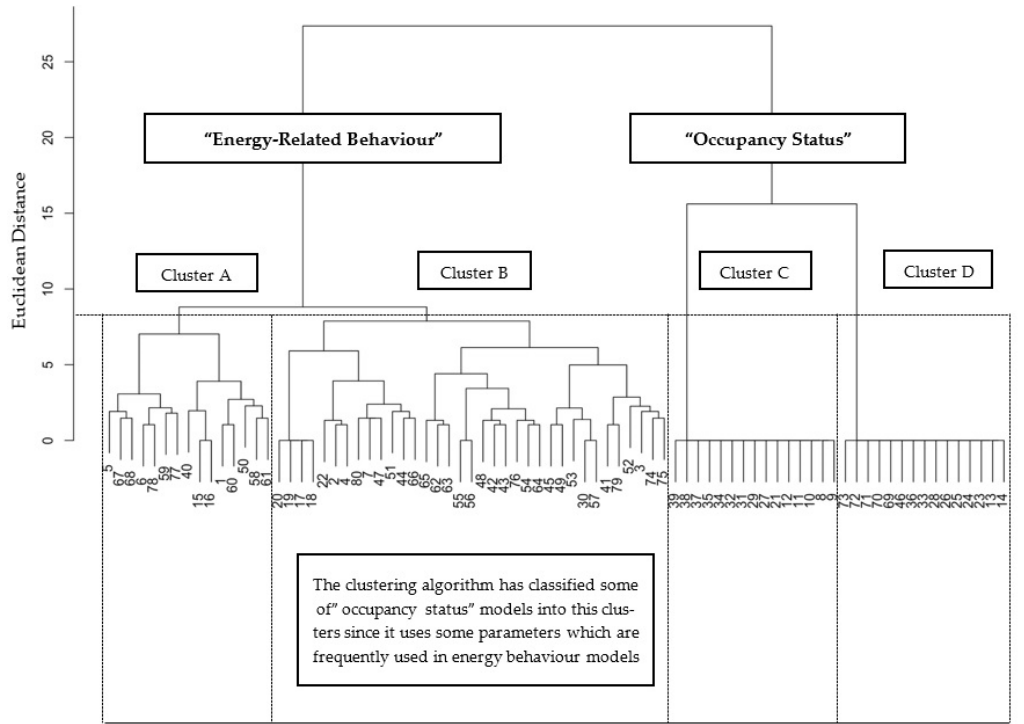
Figure 4. Dendrogram showing the classification of modelling techniques based on the parameters used in models.